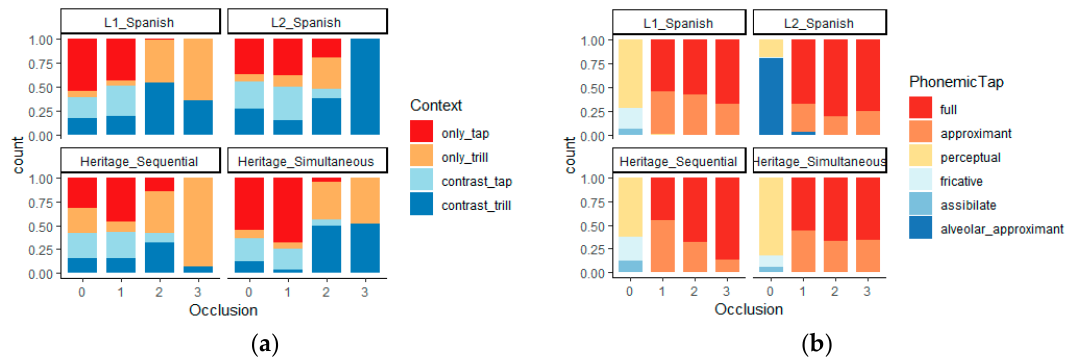
Figure 4. Bar plot for number of apical occlusions of the rhotic sounds according to participant group and ( a ) rhotic context and ( b ) phonemic tap.